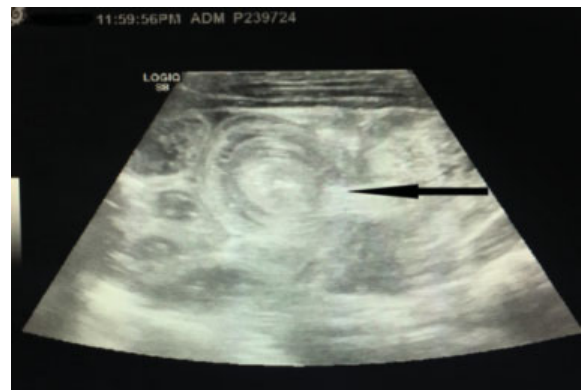
Fig. 1 Case 1: Initial abdominal ultrasound image showing classic “ doughnut sign ” of intussusception (arrow).